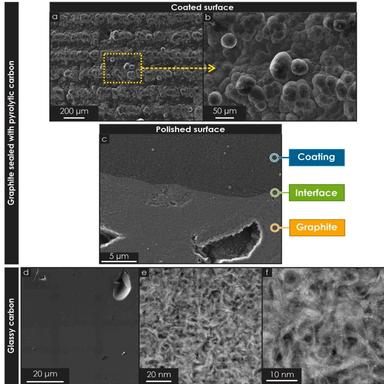
Microstructure of a graphite sample sealed with pyrolytic carbon and glassy carbon. (a) Low magnification SEM micrograph of coating of pyrolytic carbon, (b) Low magnification SEM micrograph of coating of pyrolytic carbon, (c) SEM micrograph of polished surface of graphite sealed with pyrolytic carbon, (d) SEM micrograph of glassy carbon surface, and (e) Low magnification STEM annular dark field micrographs of glassy carbon, (f) High magnification STEM annular dark field micrographs of glassy carbon.